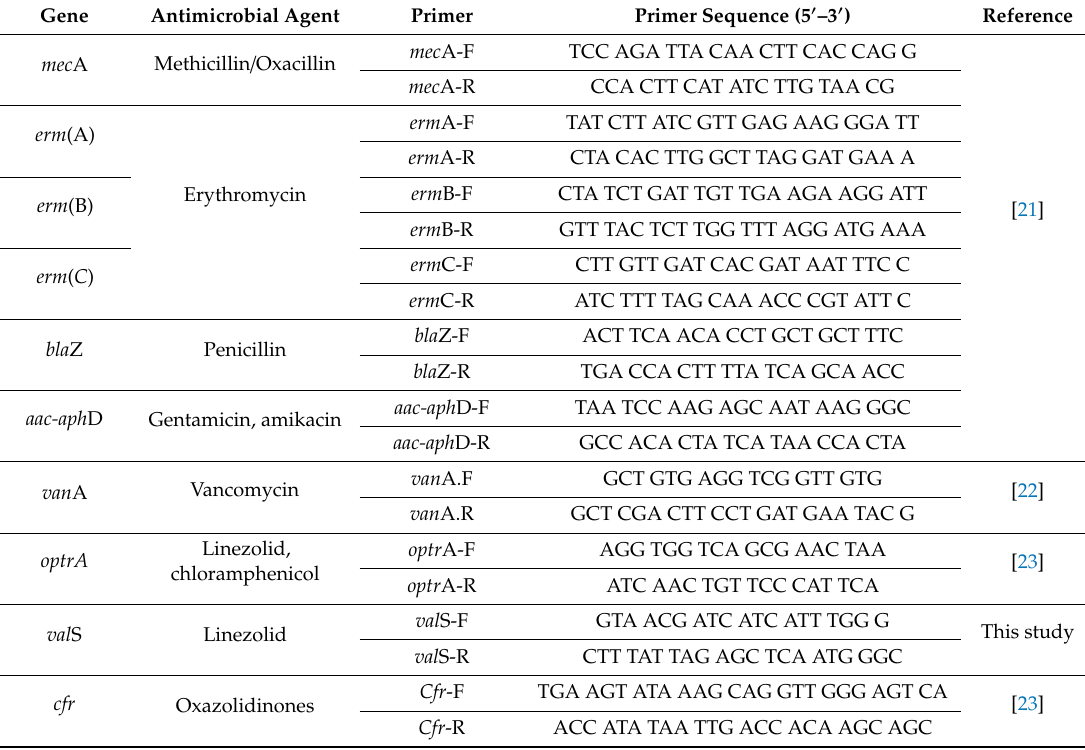
Table 3. Primers and their sequences used in this